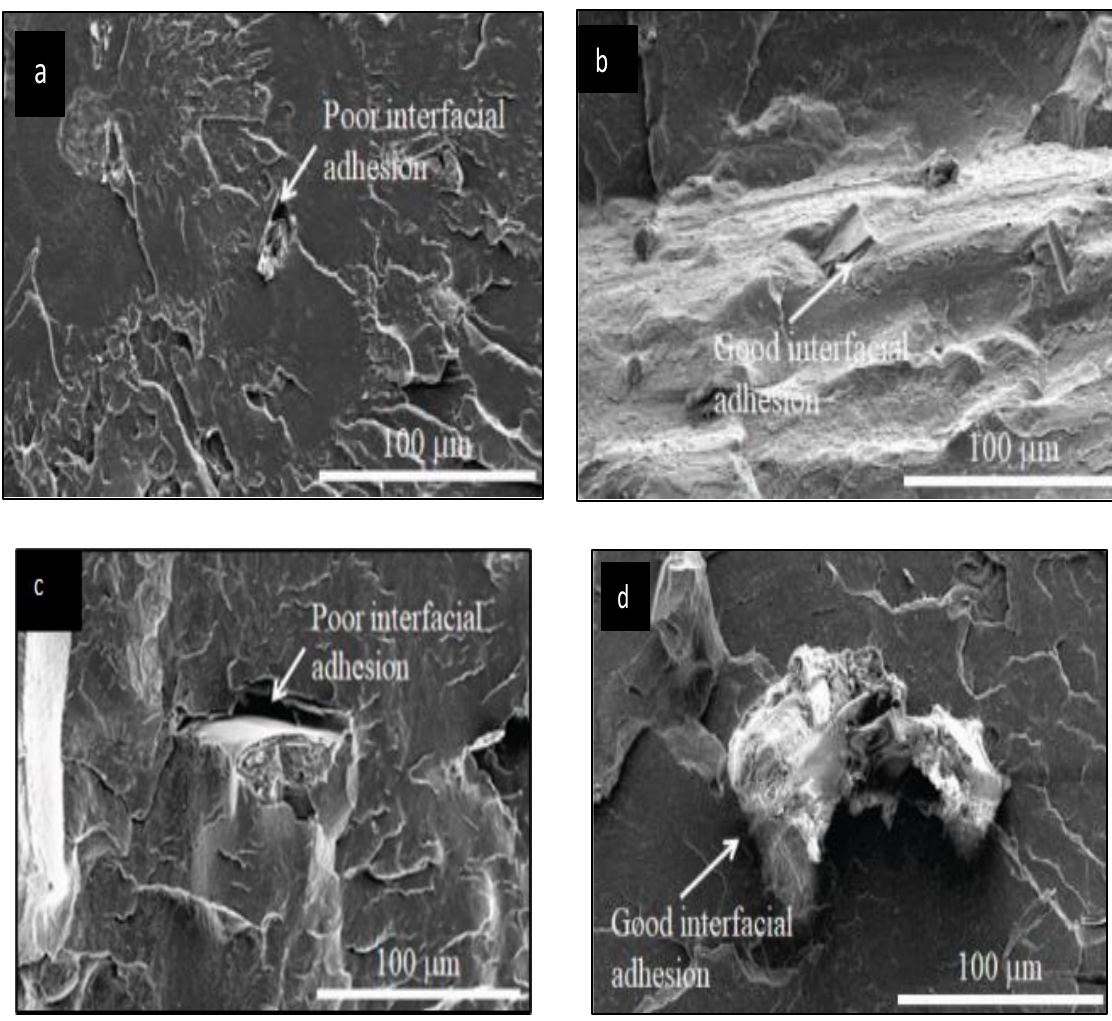
Figure 12. Scanning Electron Micrograph ( a ) Untreated wood PLA ( b ) Treated wood PLA ( c ) Untreated wood PLA ( d ) Treated wood PLA [32].